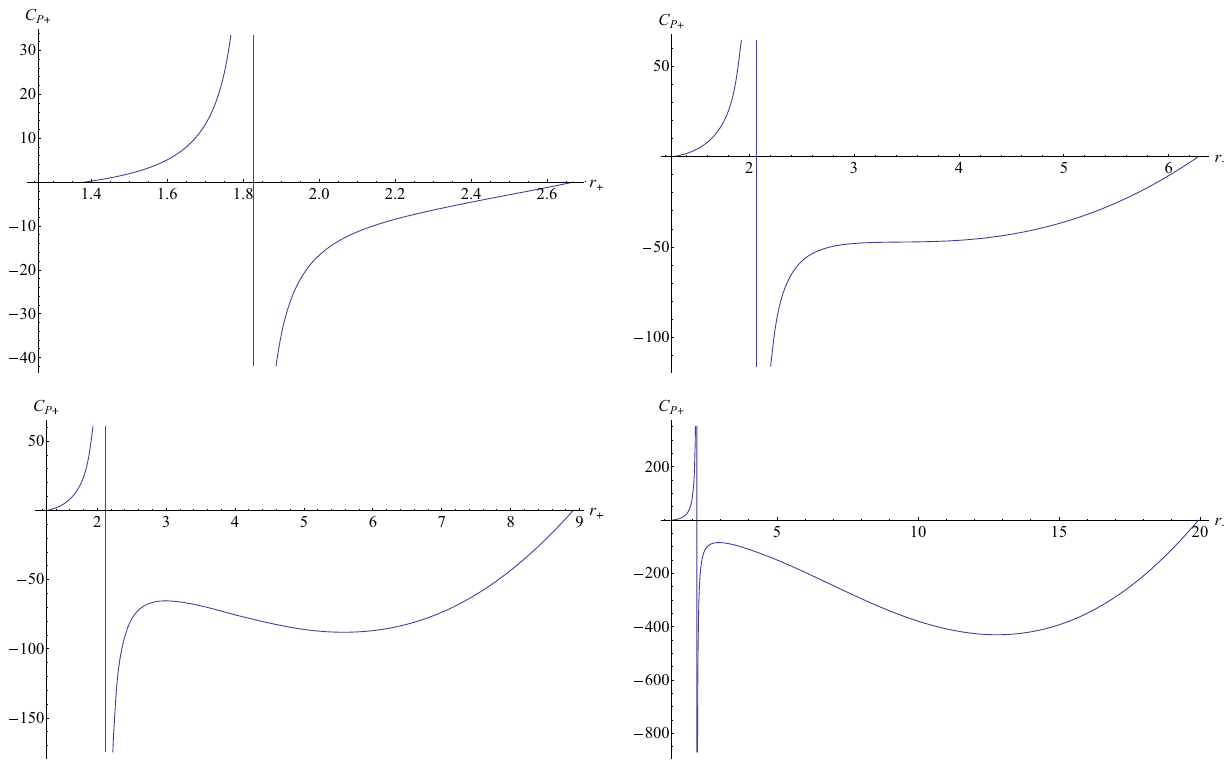
Fig. 7 We plot the heat capacity C P + in terms of the horizon radius r + , under the different values of the pressure. They correspond to P = − 0 . 005 (top left), P = − 0 . 001 (top right), P = − 0 . 0005 (bottom left), and P = − 0 . 0001 (bottom right)